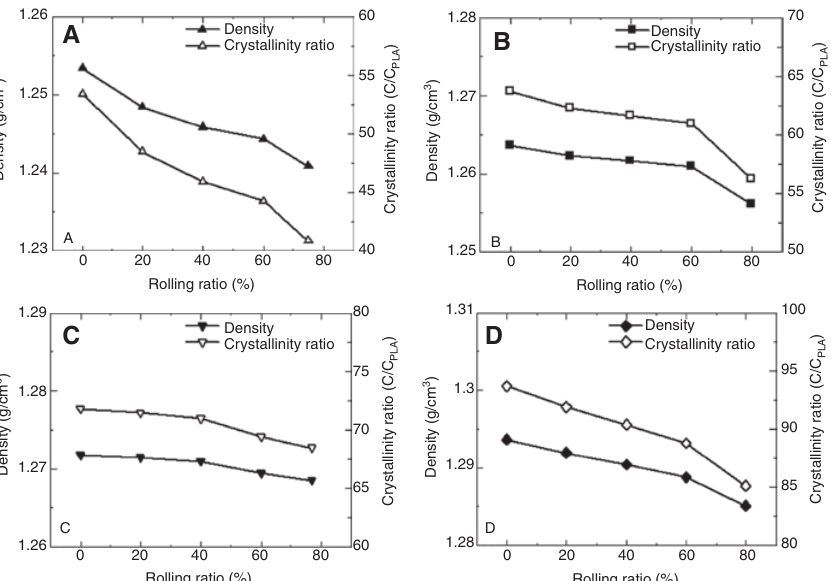
Figure 4: Effects of rolling ratio on the density and crystallinity ratio of (A) PLA/1 wt.% MWCNT, (B) PLA/3 wt.% MWCNT, (C) PLA/5 wt.% MWCNT, and (D) PLA/10 wt.% MWCNT composites.